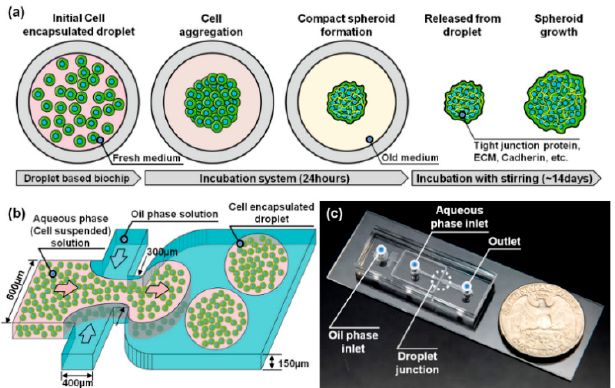
Figure 7. ( a ) The formation of a 3D tumor spheroid model from a single cell in micro-droplet. ( b ) A droplet-based microfluidic system for 3D tumor spheroid model generation. ( c ) The optical im- age of the whole device. (Reproduced from Reference